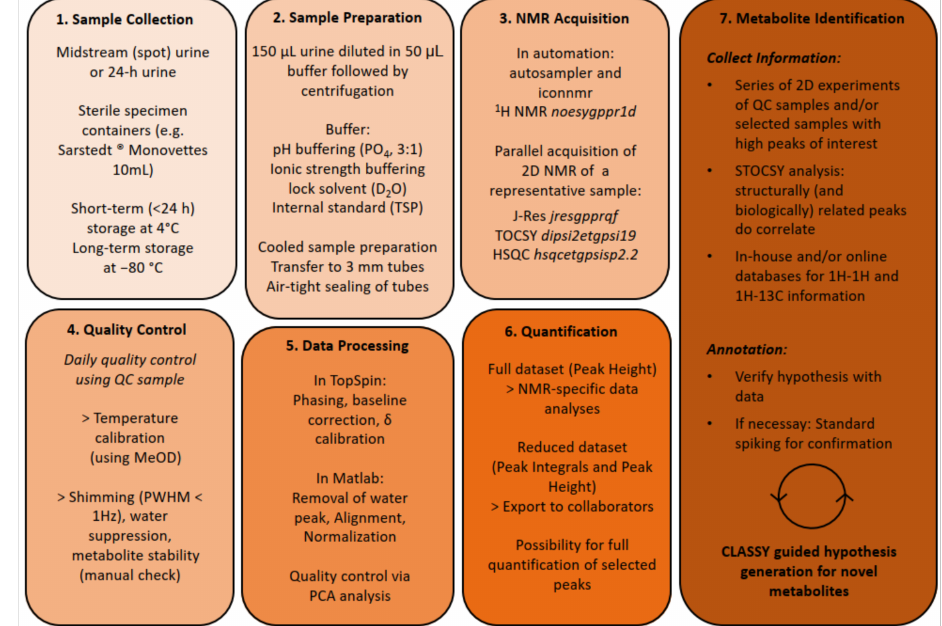
Figure 1. Overview of the standard operating procedures